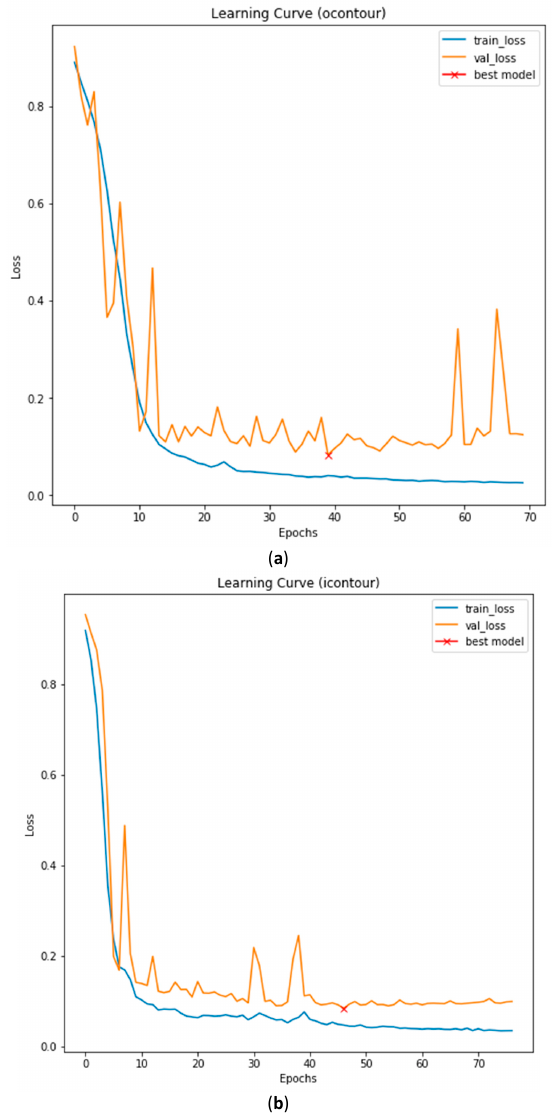
Figure 8. ( a ): Learning curve during training, minimizing dice loss for epicardium (top) and endo- cardium (bottom) using the Relu activation. ( b ): Learning curve during training minimizing dice loss for epicardium (top) and endocardium (bottom) using the Relu activation.